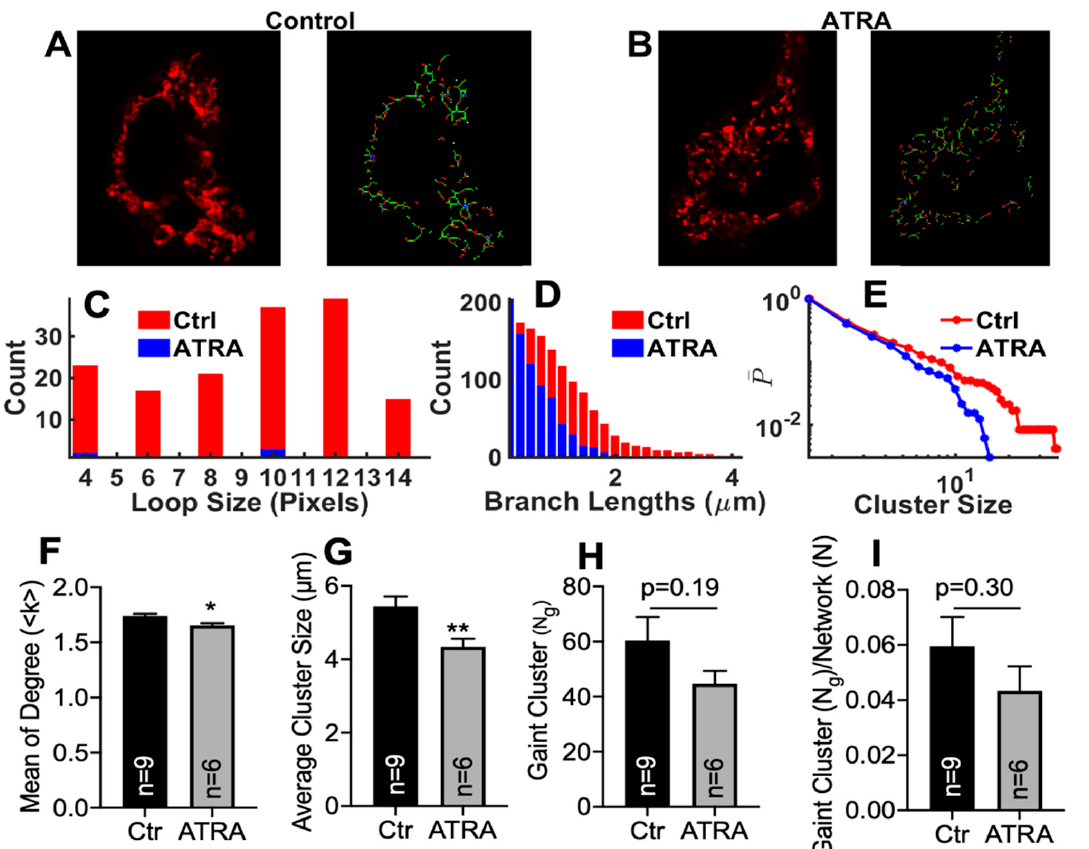
Figure 5. Microscopic properties of the mitochondrial network in control and ATRA-treated HL-1 cells. Representative confocal images of the mitochondrial network in ( A ) control and ( B ) ATRA-treated cells from experiments (left panels) and the network retrieved using image processing (right panels). Distributions of loop sizes ( C ), branch lengths ( D ), and cluster sizes ( E ) (cumulative probability) for control (red) and ATRA-treated cells (blue). Mean degree ( F ), average cluster size ( G ), giant cluster ( H ), and the giant cluster normalized to the total network size ( I ). * p < 0.05, ** p < 0.01, vs. control; unpaired 2-sample t -test.